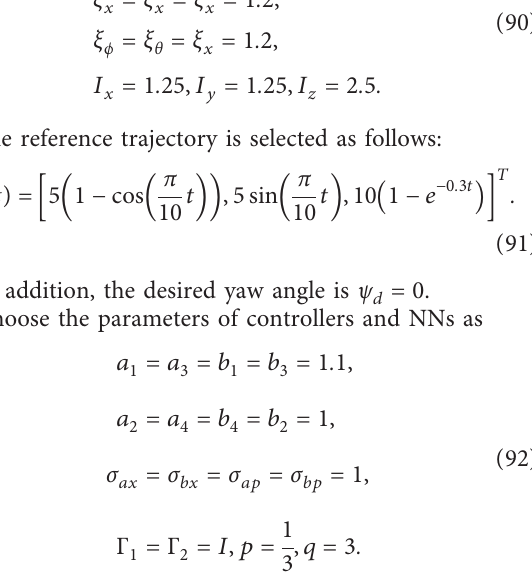
e d , and error y